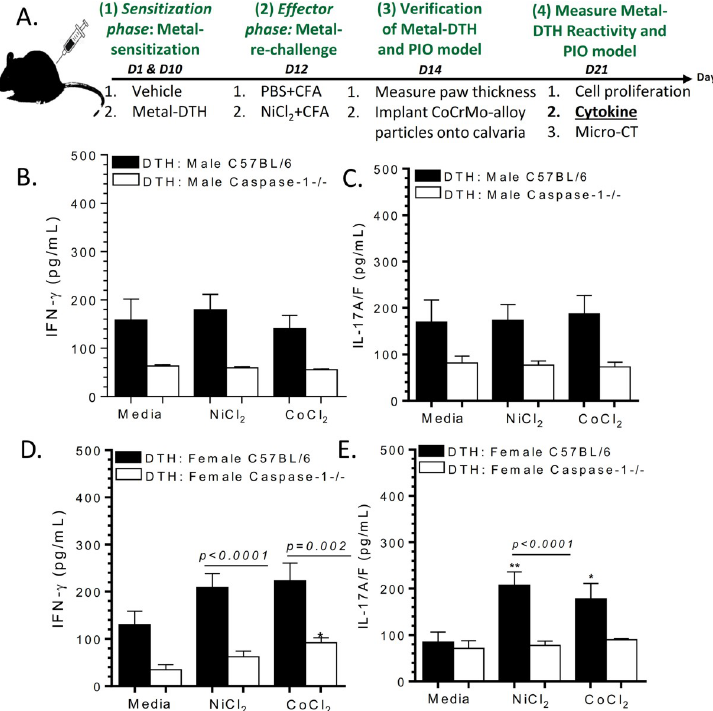
Fig 3. Female vs male BL/6 metal-DTH mice exhibit preferential IL-17A/F producing T-cells to implant metal- challenge. (A) Schematic model demonstrating experimental design. At day 21, spleens were harvested. Lymphocytes were purified from mouse spleens and co-cultured with or without Ni or Co challenge for four days and supernatants were collected and analyzed for cytokine production. Lymphocytic (B) IFN-gamma and (C) IL-17A/F production was measured from metal-DTH treated male BL/6 and Caspase-1 -/-. Lymphocytic (D) IFN-gamma and (E) IL-17A/F production was also measured from metal-DTH treated female BL/6 and Caspase-1 -/- mice. Data represents two independent experiments with n = 4–5 mice/group in each experiment. Data are shown as the mean ± SEM. Statistical significance was determined by unpaired Mann-Whitney test and asterisk ( �� ) denote significant differences at p < 0.005 and ( � ) p < 0.05 compared to respective in vitro media challenged cell group.